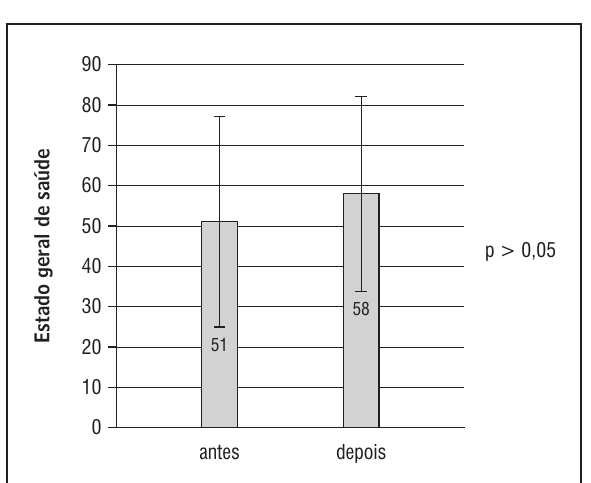
Figura 4 - Média e desvio-padrão do estado geral de saúde dos pacientes antes e depois do protocolo fisio- terapêutico (n = 27; p > 0,05)